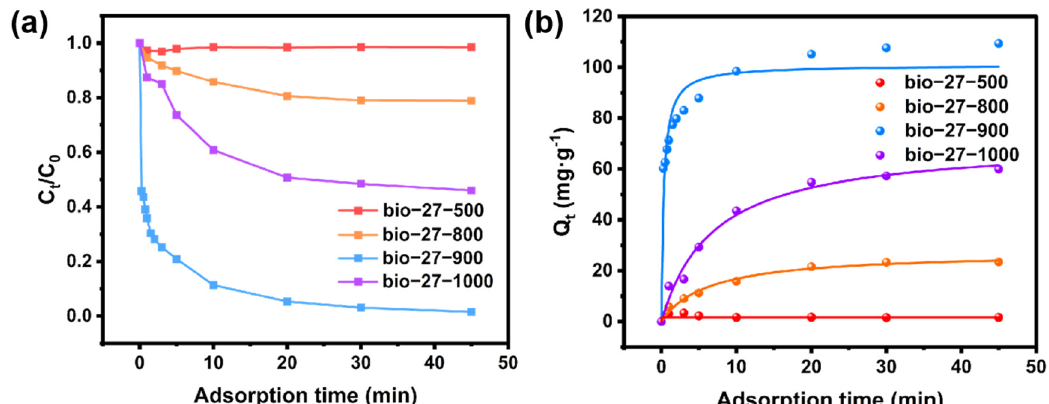
Figure 5. ( a ) Adsorption kinetics curves of bio − C − T. ( b ) The corresponding fitted pseudo-second- order adsorption kinetics. Reaction conditions: SMX = 10 mg/L, reaction volume = 50 mL, catalyst dosage = 180 mg/L, initial solution pH = 7, temperature = 25 °C, reaction time = 45 min). Table 3. Pseudo-second-order adsorption kinetics fitting values.